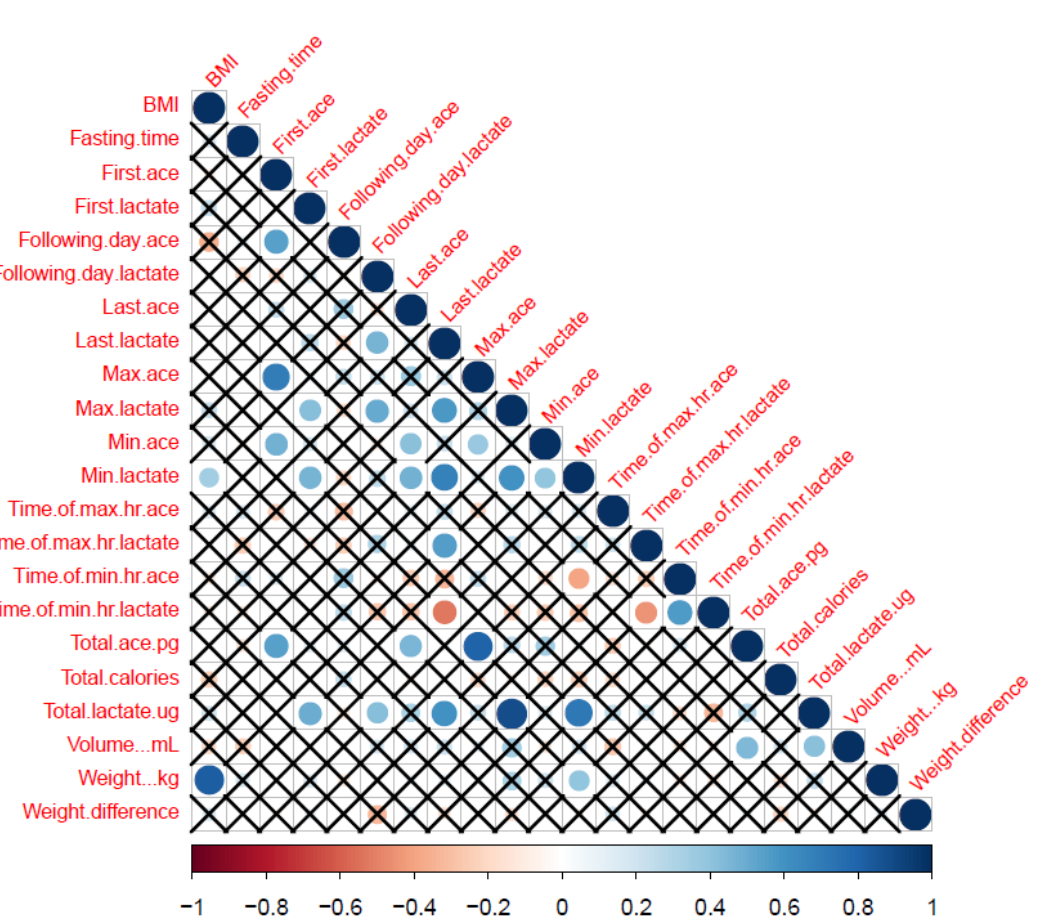
Figure 6. Correlation Matrix for ACE and Lactate. Correlations between the parameters were scaled from + 1.0 to − 1.0. Blue indicates positive correlation while red indicates negative correlation. X indicates no correlation between the two parameters which is significant at p = 0.05.